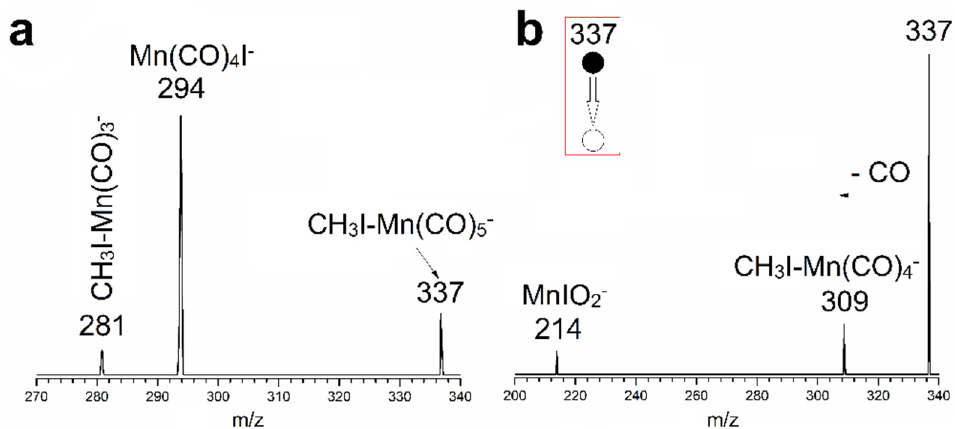
Figure 2. Mass spectrometric results. ( a ) A typical mass spectrum showing the reaction products between Mn(CO) 5 − and CH 3 I; ( b ) CID mass spectrum of [Mn(CO) 5 (CH 3 I)] − at m/z 337 taken with the MS 3 mode. The nominal applied CID voltage is 5 V.